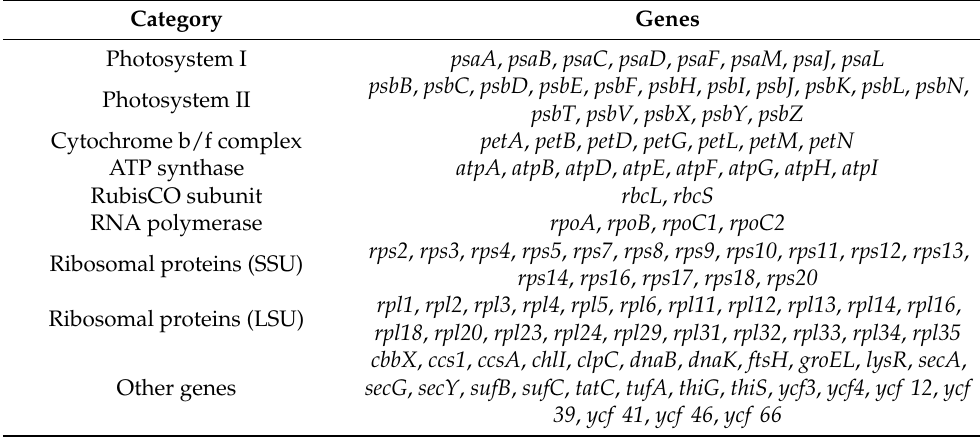
Table 1. 108 shared protein-coding genes of cpDNAs in Bacillariophyceae.